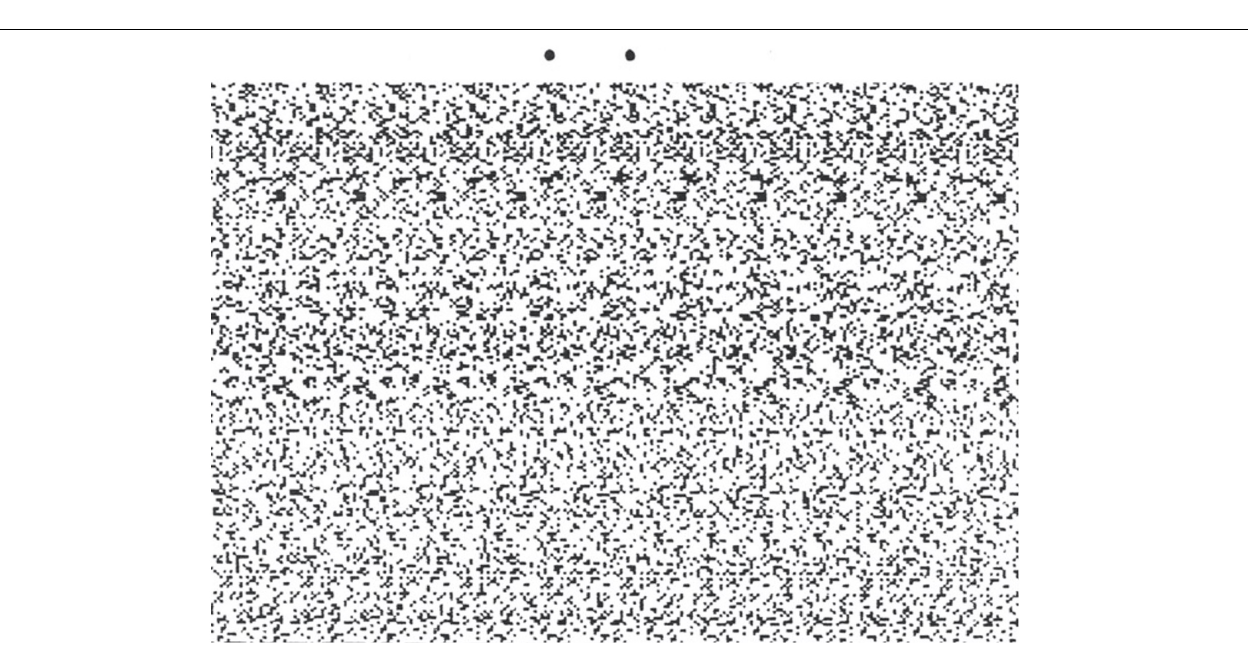
FIGURE 4 | Autostereogram of horizontal corrugations. For free-viewing of the depth impression, converge or diverge the eyes so as to see the pair of dots at the top as a triplet, when the depth impression should emerge in the texture region. From Tyler and Clarke (1991).